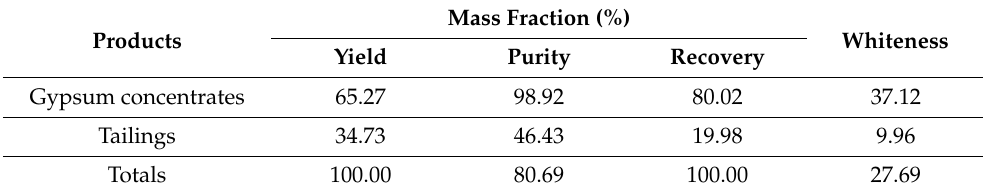
Figure 8. The recovery of gypsum from phosphogypsum using grading and flotation. Table 5. Entire flowsheet test results of the recovery of gypsum from phosphogypsum.